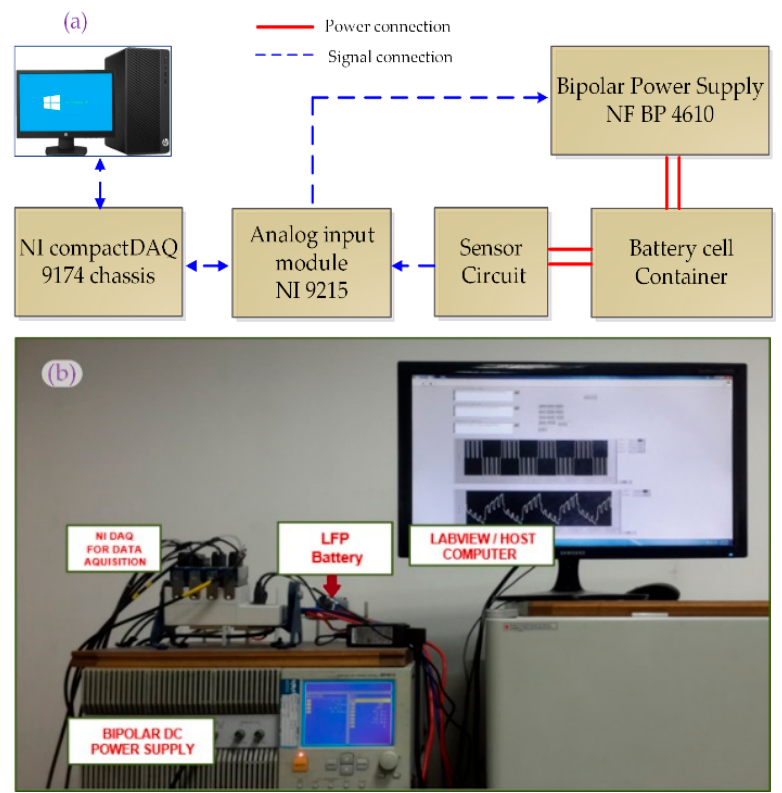
Figure 4. Experimental setup: ( a ) Block diagram; ( b ) Picture.